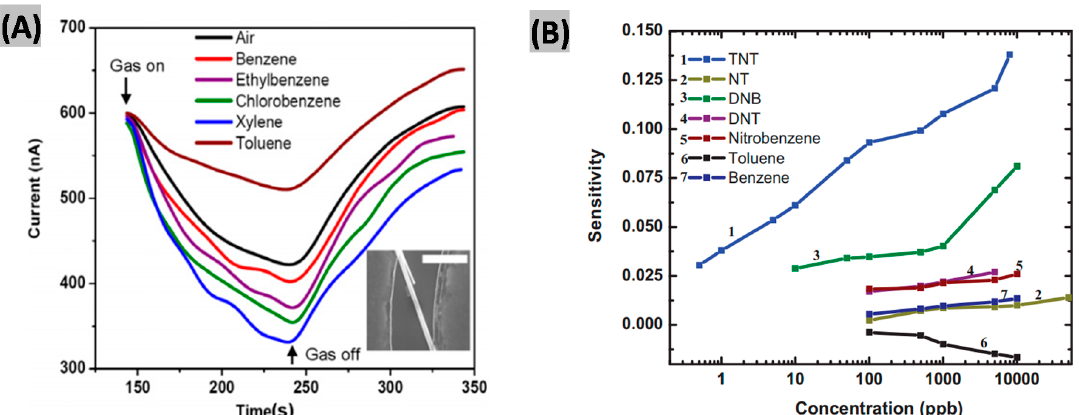
Figure 3. ( A ) Variation of sensor current of the GaN/TiO 2 device toward 1000 ppm of different aromatic compounds’ vapor with a reference of air response in the presence of UV light. Figures adapted with permission from [55], Copyright 2011 IOP Publishing Ltd. ( B ) Sensitivity profile of the synthesized device in presence of 1 ppm of different aromatics and nitro-aromatics. Figures adapted with permission from [56], Copyright 2013 IEEE.